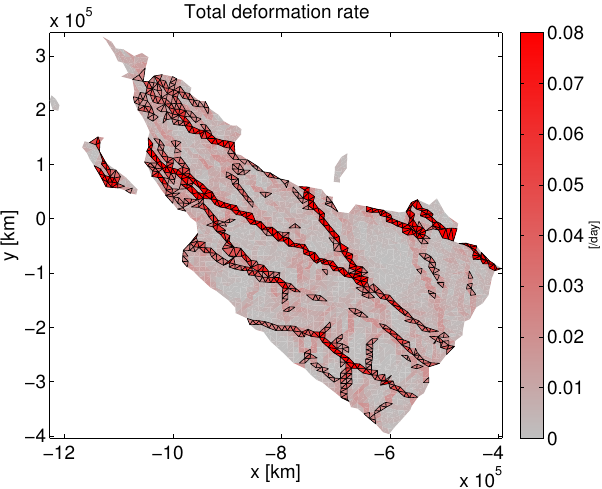
Figure 6. Filtered divergence rate after the application of the smoother to the selected cells (see Fig. 5). In this example, the pa- rameter n is set to 3. The triangles that have been treated by the smoother are those in black in Fig. 5. For the other triangles, the value of the deformation remains the same as in Fig.